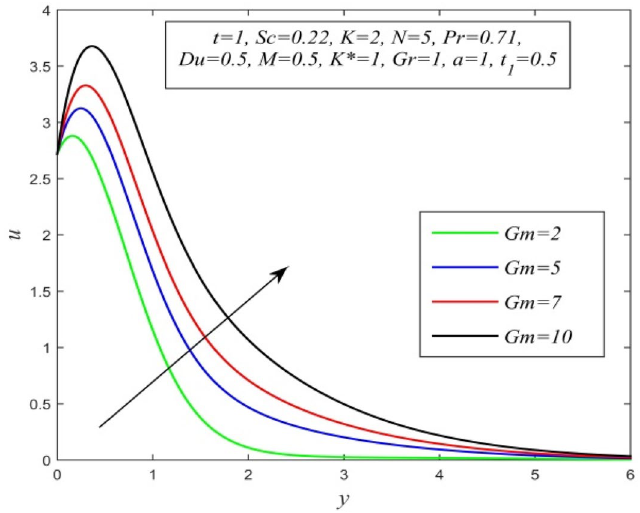
Figure 17. u versus y for different Gm and t = 1, Sc = 0.22, K = 2, N = 5, Pr = 0.71, Du = 0.5, M = 0.5, K* = 1, Gr = 1, a = 1, t 1 = 0.5.